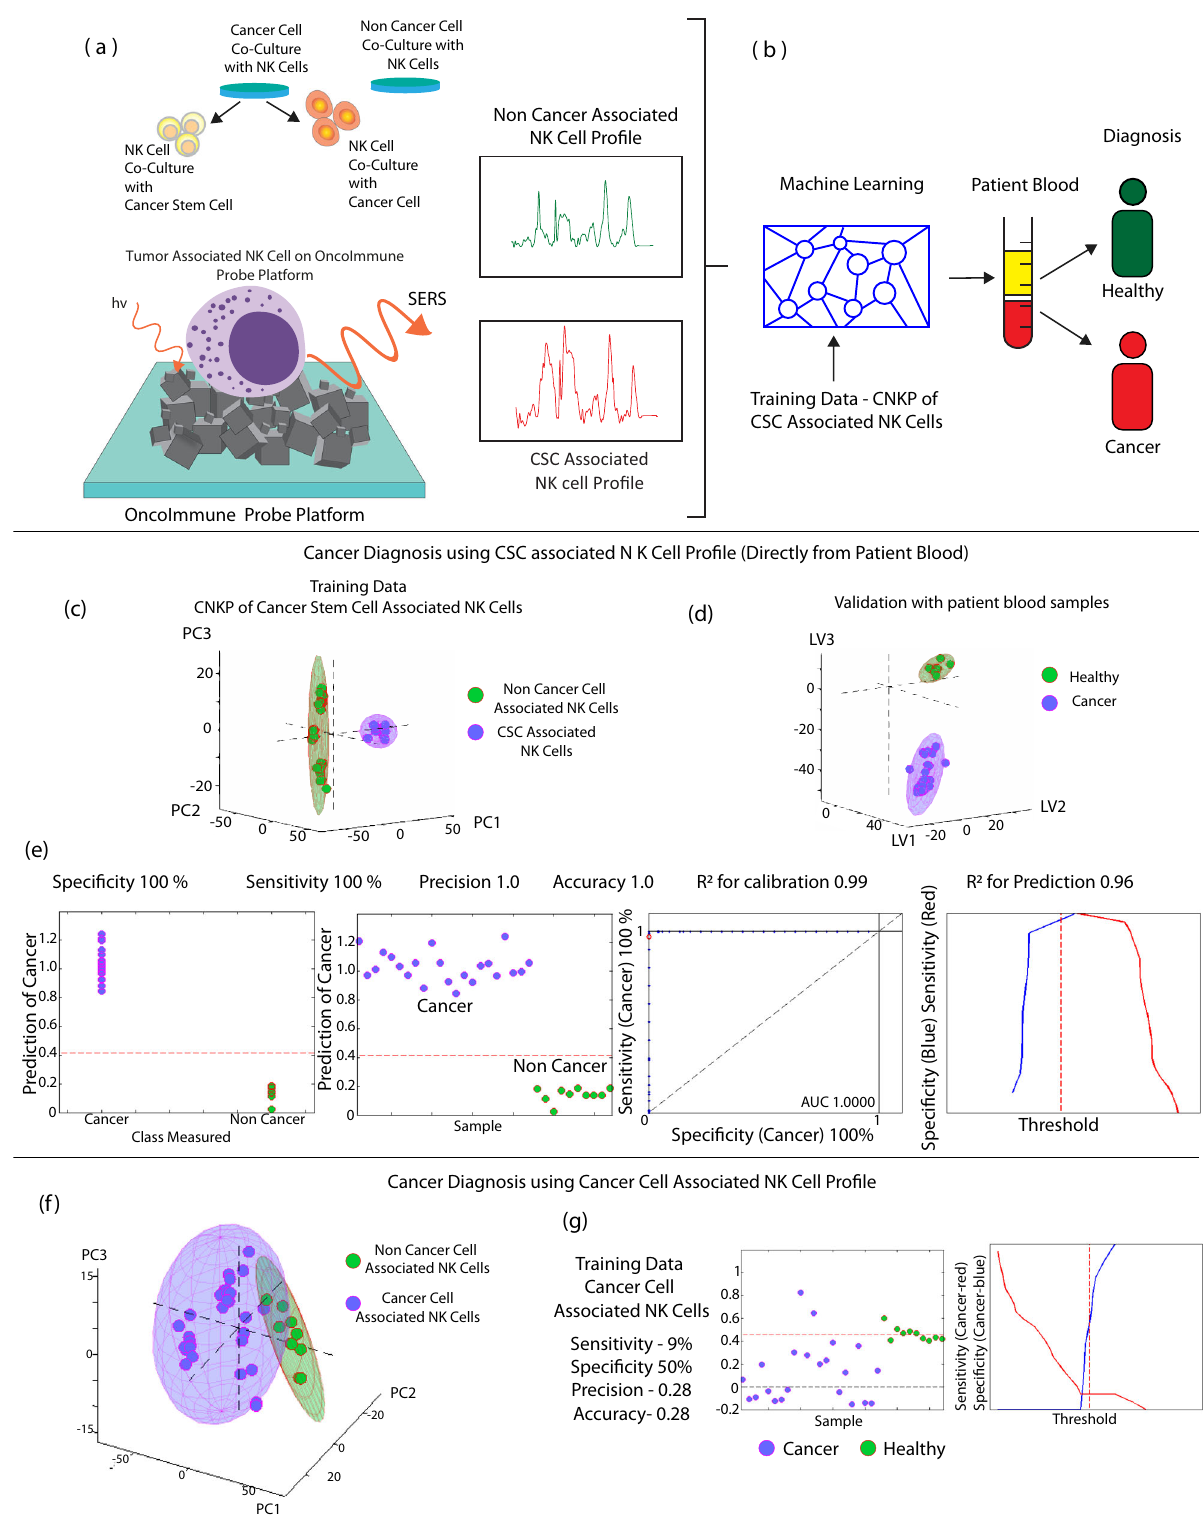
Fig. 8 | Prediction of tumor-associated NK cells directly with patient blood (without cellular isolation) using CNKP for cancer diagnosis. a Schematic representation of training data from cell culture (representative Raman spectra — non-cancer-associated NK cell-green, csc-associated NK cell — red). Source data are provided as Source Data File. b Schematic representation of liquid biopsy. c Prediction of tumor-associated NK cell directly from patient blood with CSC- associated NK cell pro fi le using exploratory training data from csc-associated NK